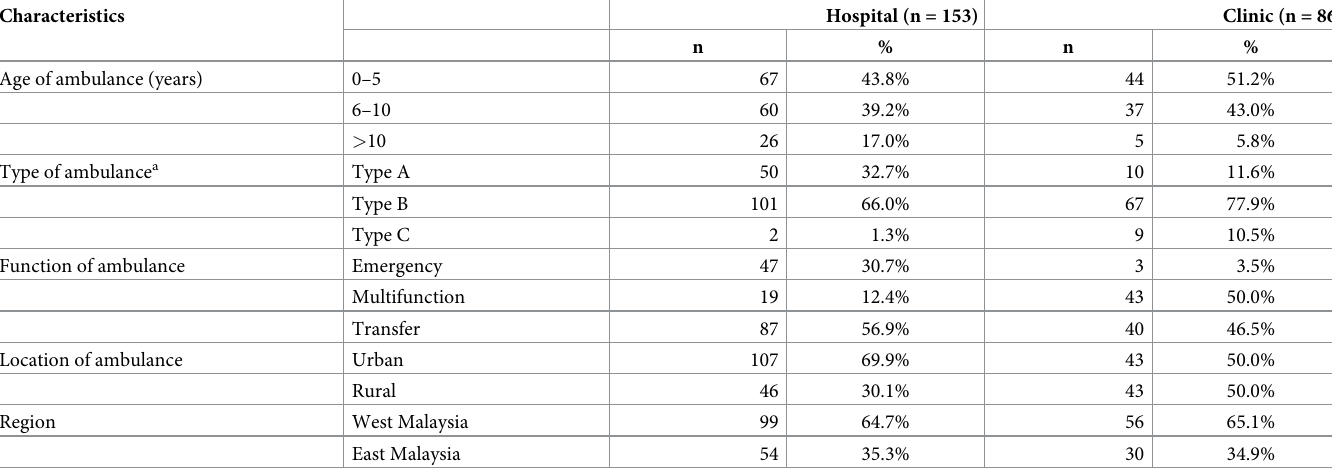
Table 2. Characteristics of ambulance (n = 239).